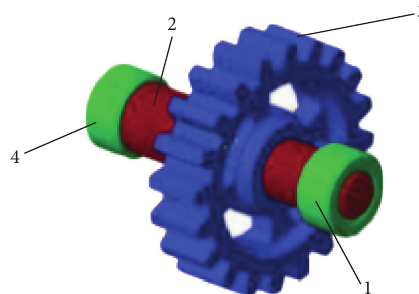
Figure 1: The structural diagram of the gearbox system.